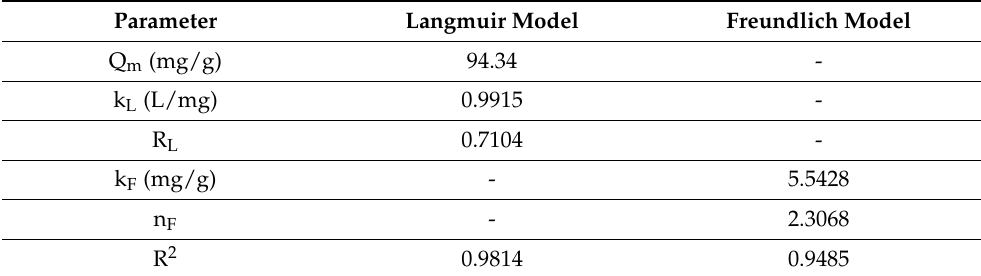
Table 2. Langmuir and Freundlich models of CPX biosorption process on Saccharomyces cere- visiae /calcium alginate beads.